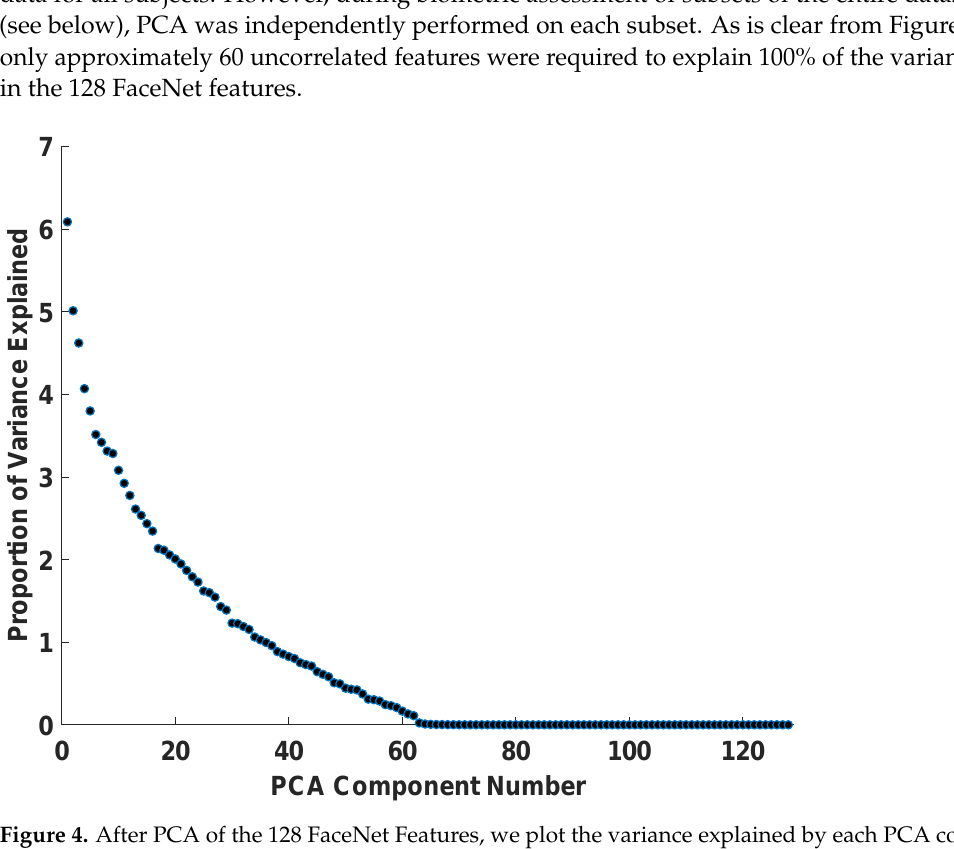
Figure 4. After PCA of the 128 FaceNet Features, we plot the variance explained by each PCA com- ponent against component number. Essentially all of the variance is accounted for by approximately 60 completely uncorrelated PCA